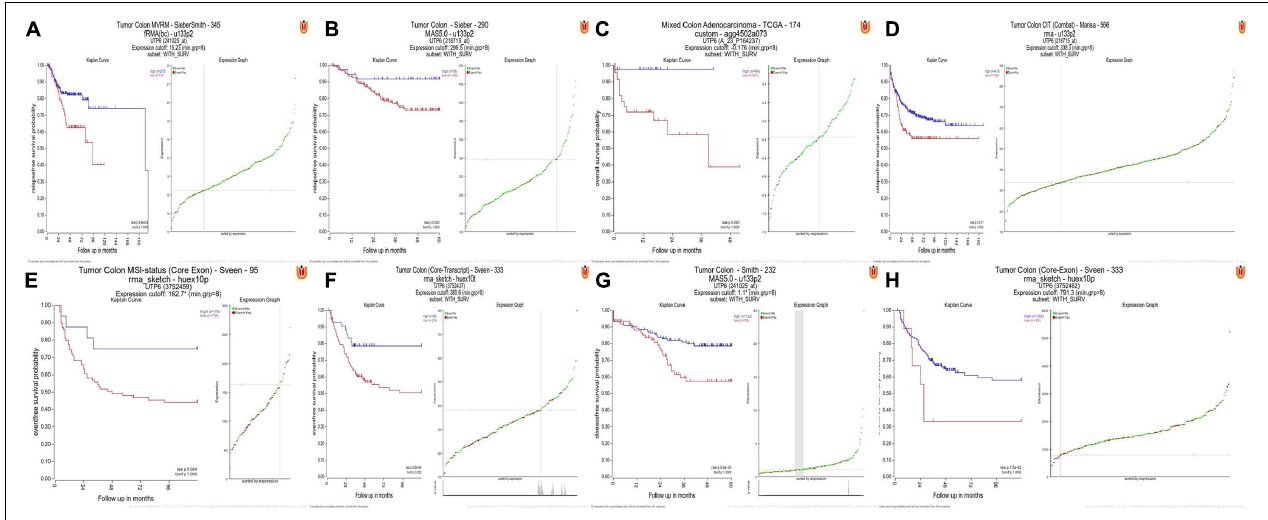
FIGURE 5 | High UTP6 expression was associated with a better event-, disease-, and relapse-free survival. (A–H) High UTP6 expression was associated with a significantly better event-, disease- and relapse-free survival (both P <